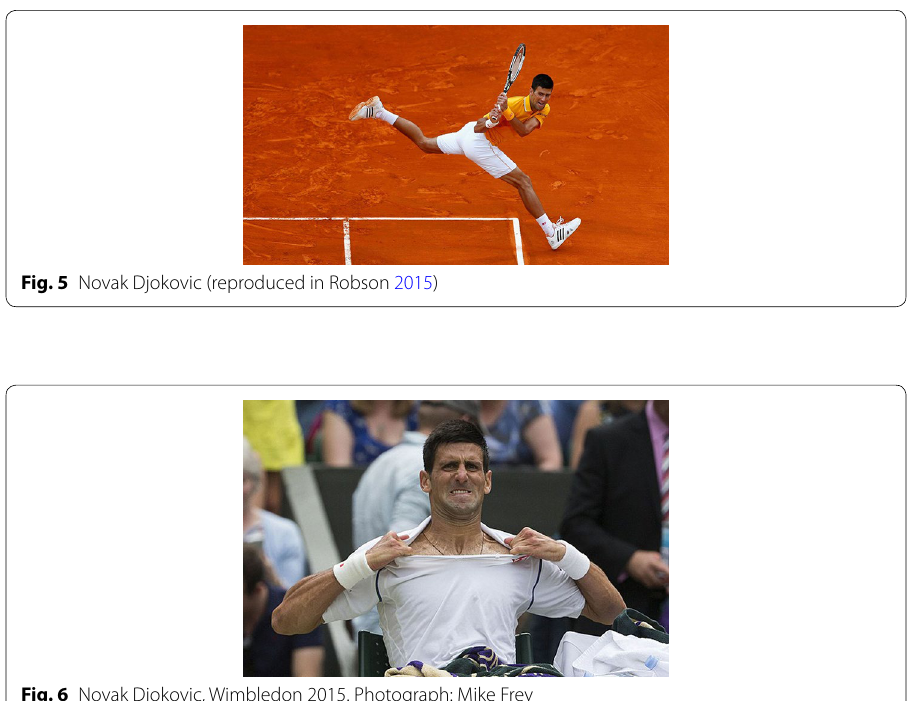
Fig. 6 Novak Djokovic, Wimbledon 2015. Photograph: Mike